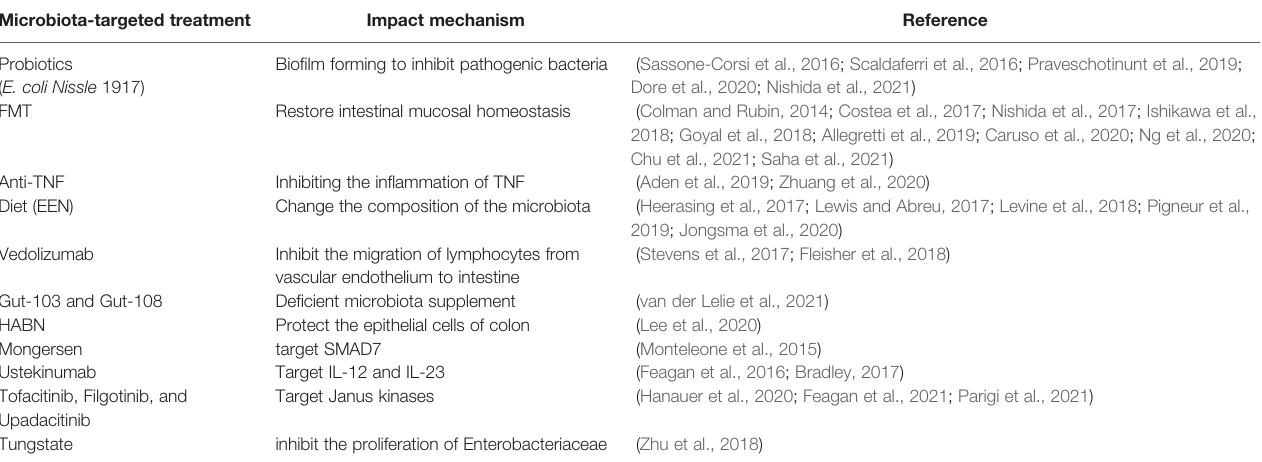
TABLE 2 | The impact mechanism of gut microbiota-targeted treatment in IBD. Microbiota-targeted